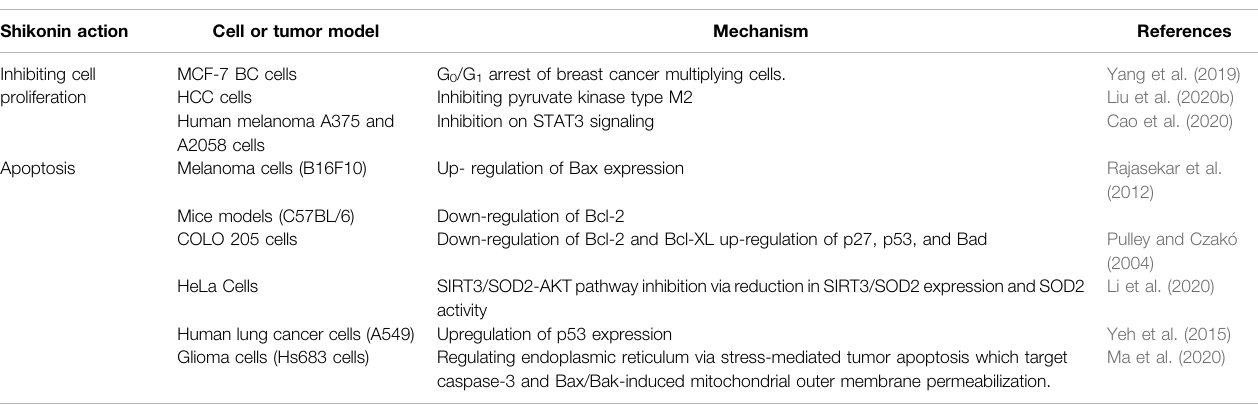
TABLE 5 | Recent anti-tumor and anti-cancer studies. Shikonin